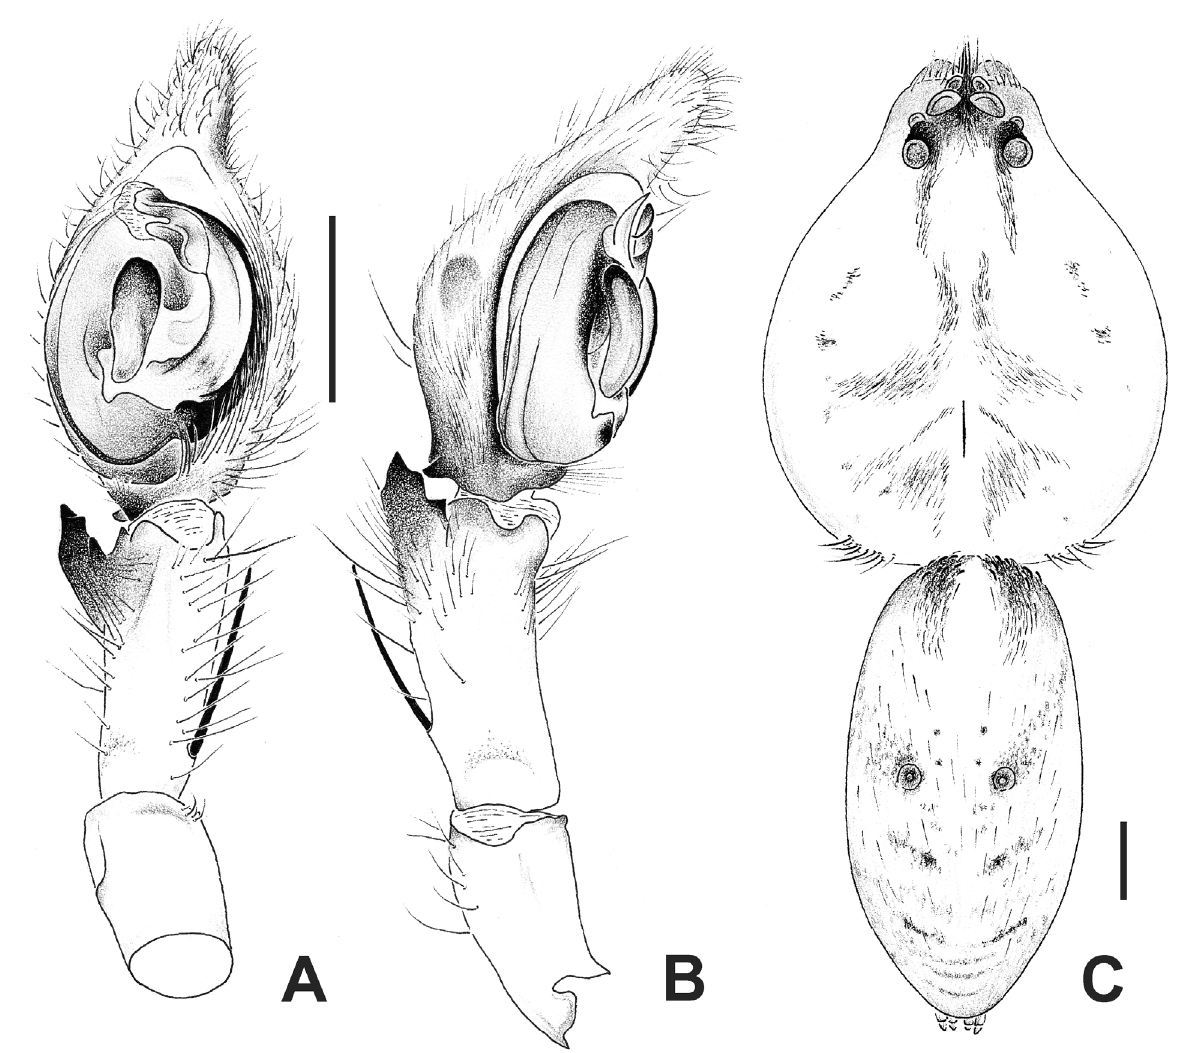
Fig. 11. Afroneutria hybrida sp. nov., ♂. A . Palp, ventral view. B . Palp, retrolateral view. C . Habitus, dorsal view. Scale bars = 1